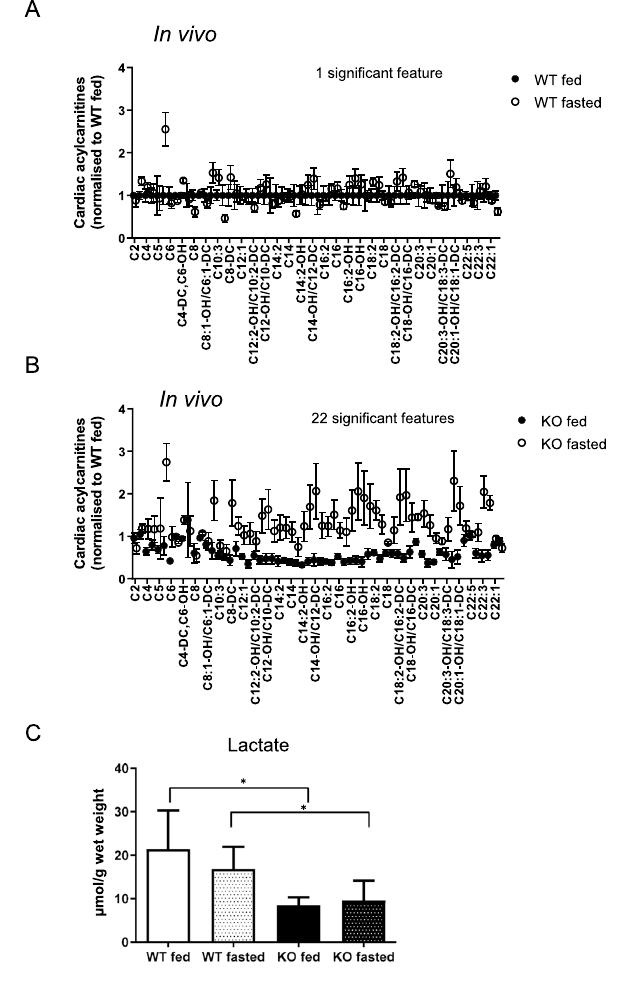
Figure 3. SIRT3 KO mice adapt better to oxidise fatty acids under fasted conditions, whilst WT hearts have a low degree of metabolic adaptation and preferentially respire glucose. ( A ) Profile of in vivo cardiac fatty acids from fed and fasted WT mice, with one significantly different feature (analysed by Two Way ANOVA, n = 6 for WT fed, n = 7 for WT fasted, *P ≤ 0.05). ( B ) Profile of in vivo cardiac fatty acids from fed and fasted SIRT3 KO mice, with 22 significantly different features (analysed by Two Way ANOVA, n = 6 for SIRT KO fed, n = 7 for SIRT KO fasted *P ≤ 0.05). ( C ) Profile of in vivo lactate is significantly higher in WT fed and WT fasted hearts vs hearts from fed and fasted SIRT3 KO mice (analysed by Two Way ANOVA with Tukey post-test, n = 4 for WT fed, n = 4 for WT fasted, n = 3 for SIRT3 KO fed, n = 4 for SIRT3 KO fasted *P ≤